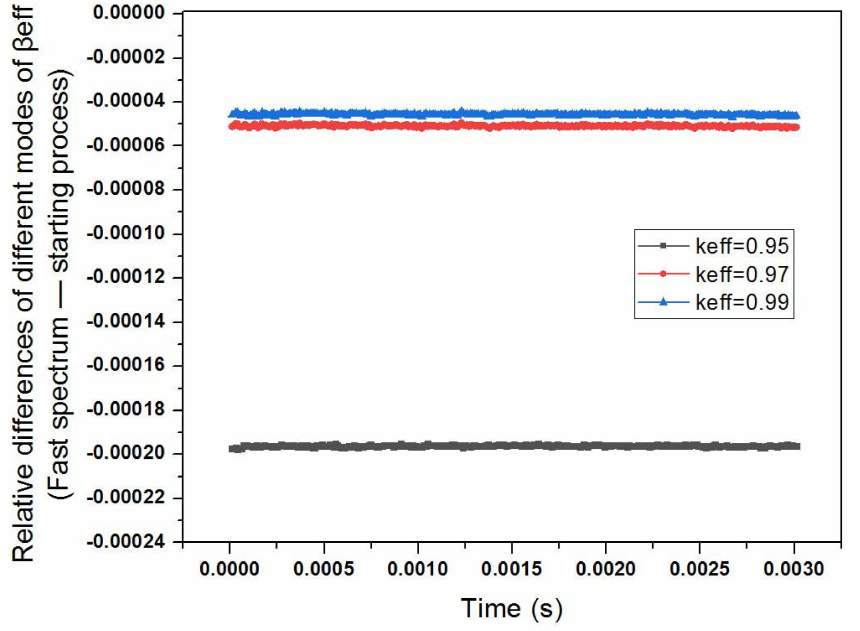
Figure 8. Relative differences in β eff with time for different modes of the fast spectrum, under different subcriticalities and starting